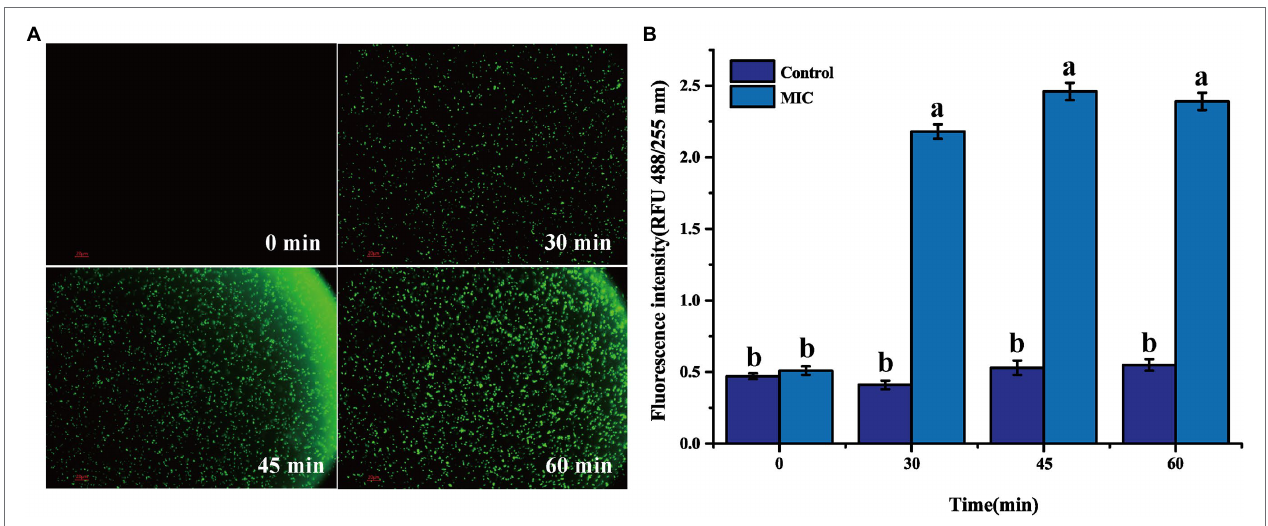
FIGURE 5 | Reactive oxygen species (ROS) fluorescence picture of L. monocytogenes (A) ; ROS fluorescence intensity (B) . Different letters in the figure indicate significant difference ( p <